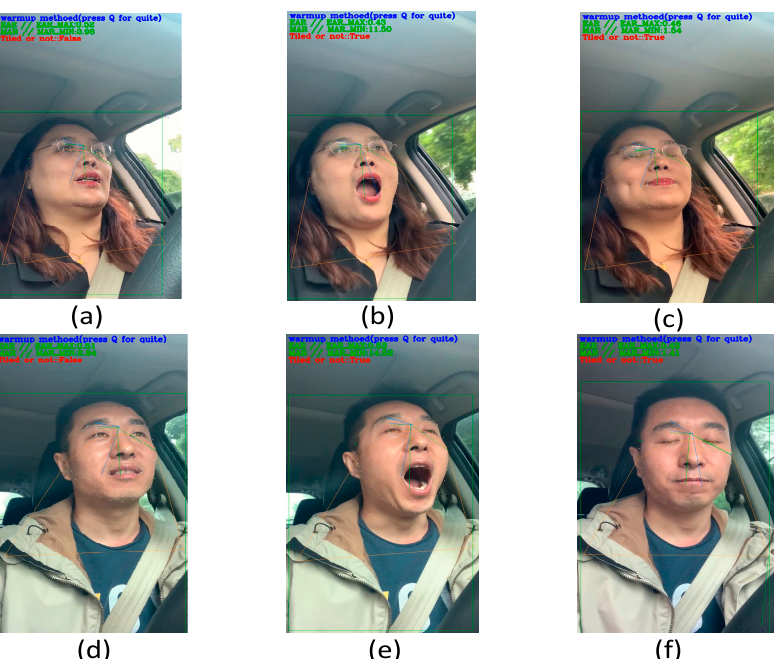
Figure 12. The effect of the original detection method on the actual scene. (a) Female normal driv- ing; (b) Female driver yawning; (c) Female drivers close their eyes; (d) Male normal driving; (e) Male driver yawning; (f) Male drivers close their eyes.